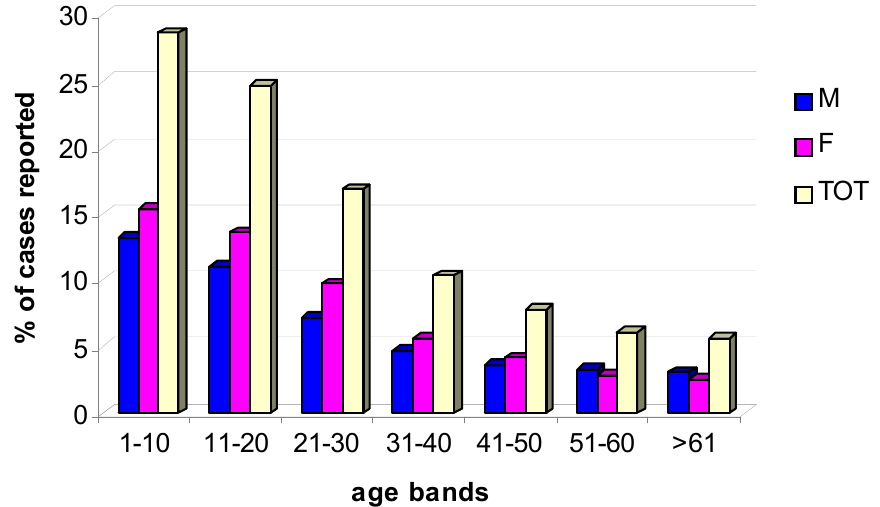
Figure 5. Distribution of cases of jellyfish stings in relation to patient gender (M, male; F, female) and